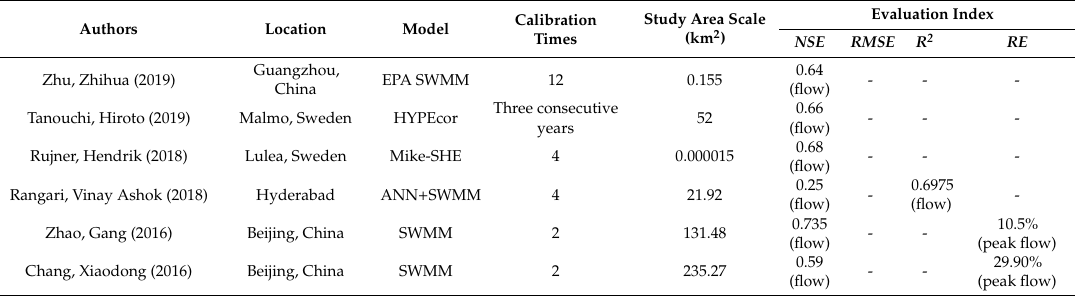
Table 3. Multiple rainfall statistics